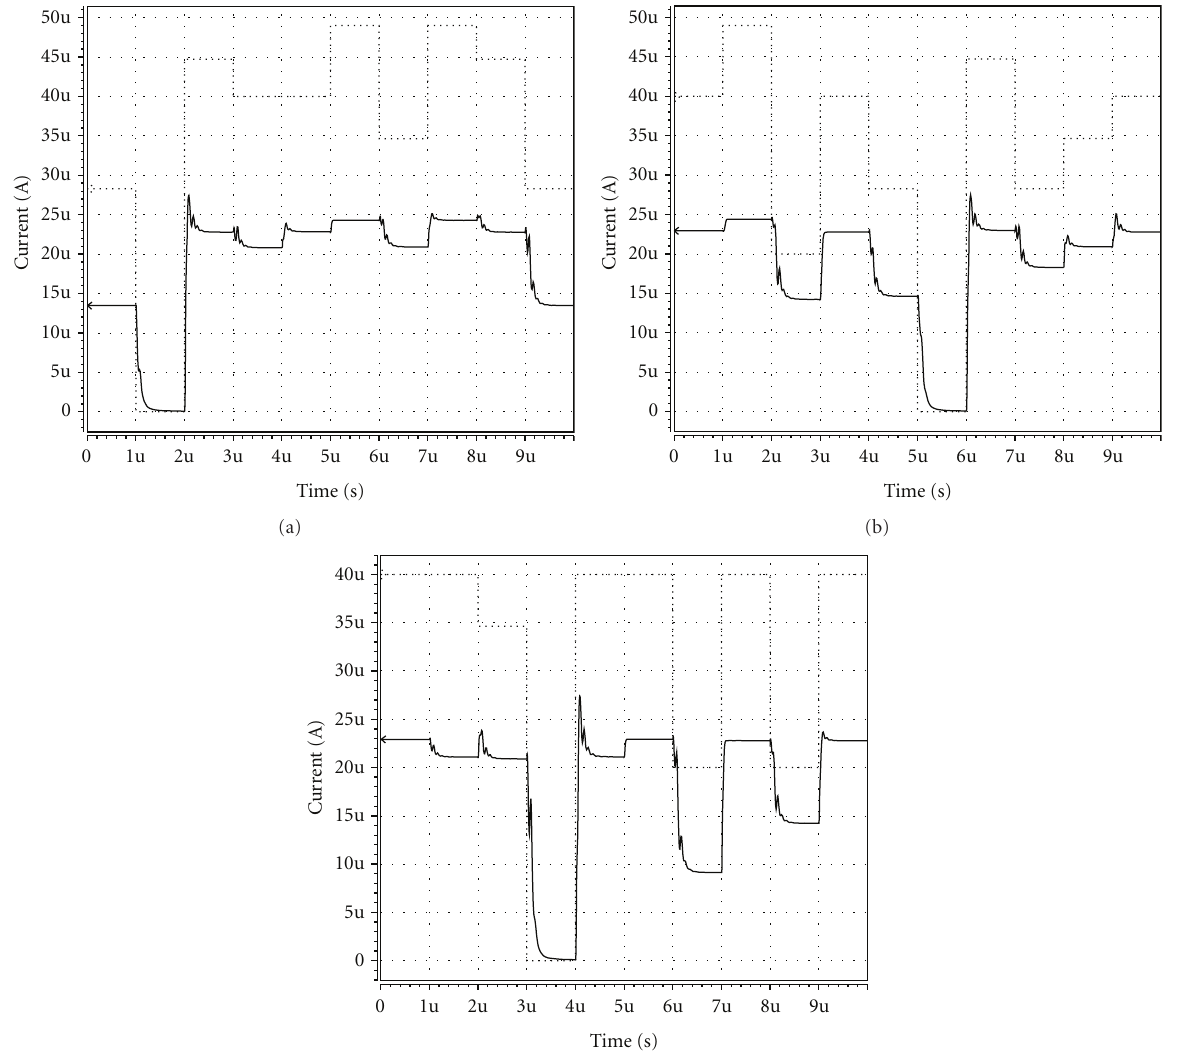
Figure 7: Time response of the Euclidean distance calculator circuit for input patterns of (a) U 1, (b) U 2 and (c) U 3